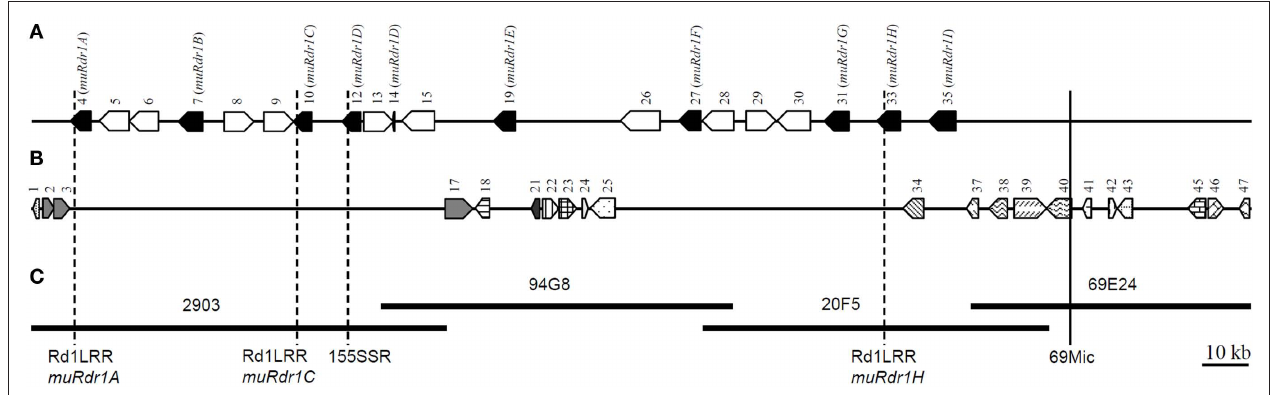
Figure 1 | Physical positions of the Rdr1 gene region and schematic representation of positions of predicted genes in the R. multiflora genotype. (A) Nine TNLs (black pentagon) and 10 transposable-elements (unfilled pentagon). (B) Other genes distributed along the Rdr1 region. (C) The completely sequenced four overlapping BAC clones carrying the Rdr1 gene.